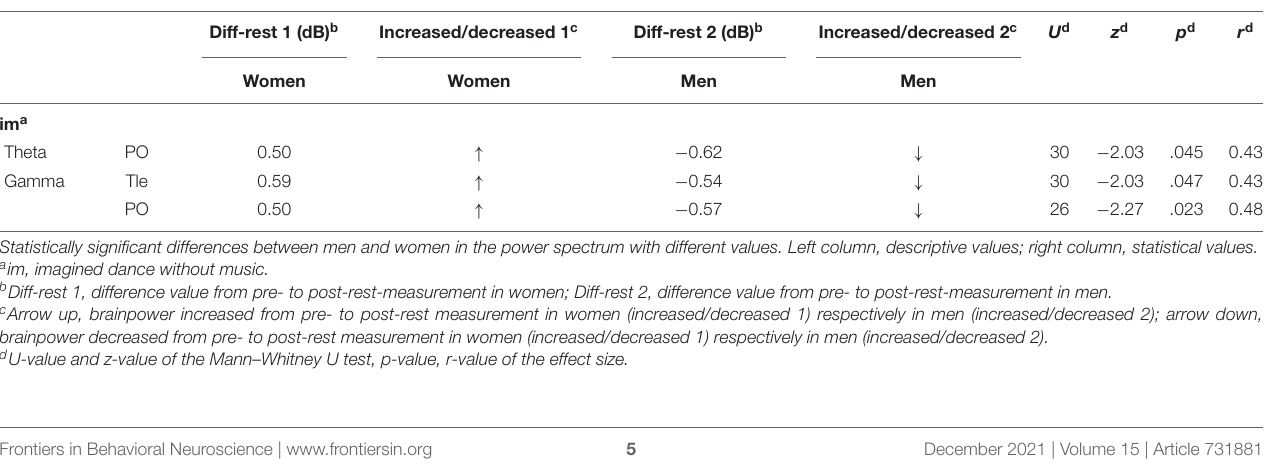
TABLE 1 | Significant between-sex/gender differences in test conditions in the power